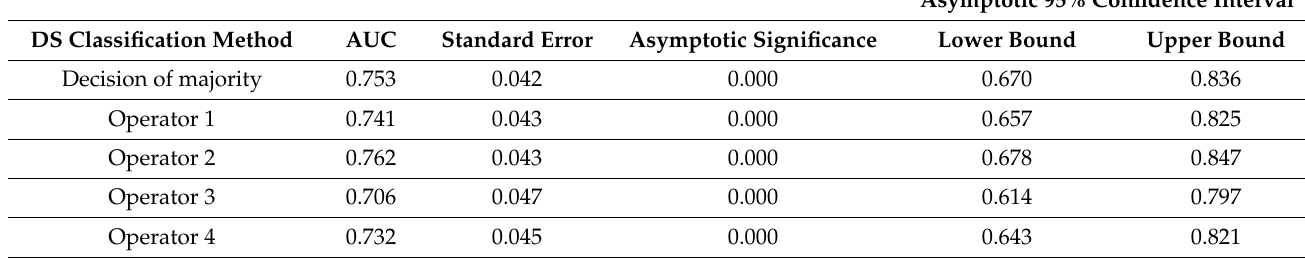
Table A6. Results from area under ROC curve analysis for the relation between degree of DS and the functional significance of the lesions (FFR ≤